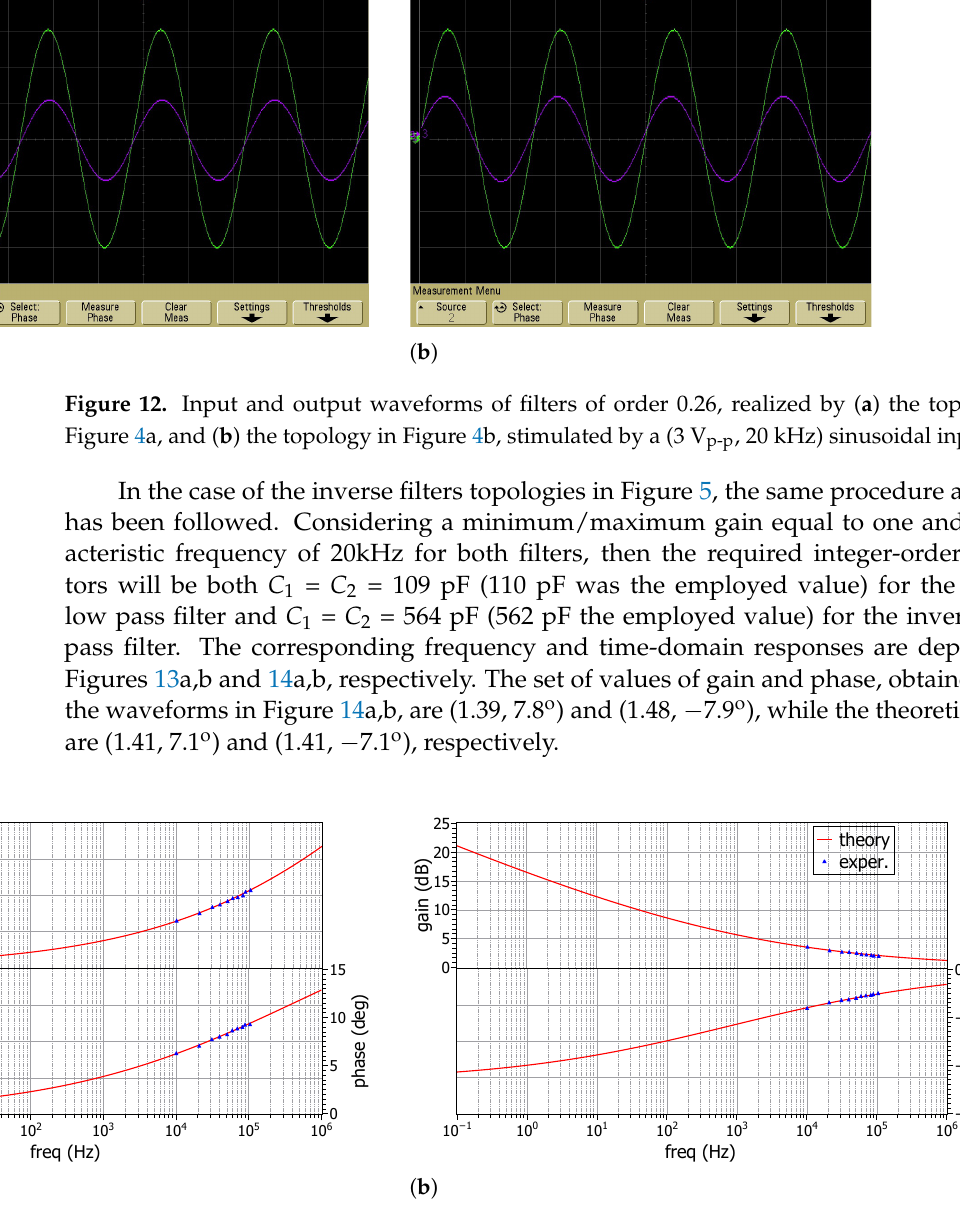
Figure 13. Frequency responses of inverse filters of order 0.26, realized by ( a ) the topology in Figure 5a, and ( b ) the topology in Figure